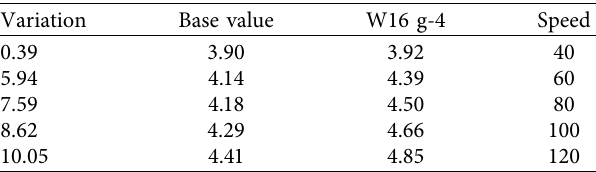
Table 5: Percentage of changes in overturning angle on slope state of − 4% and wind speed of 16 km/h.